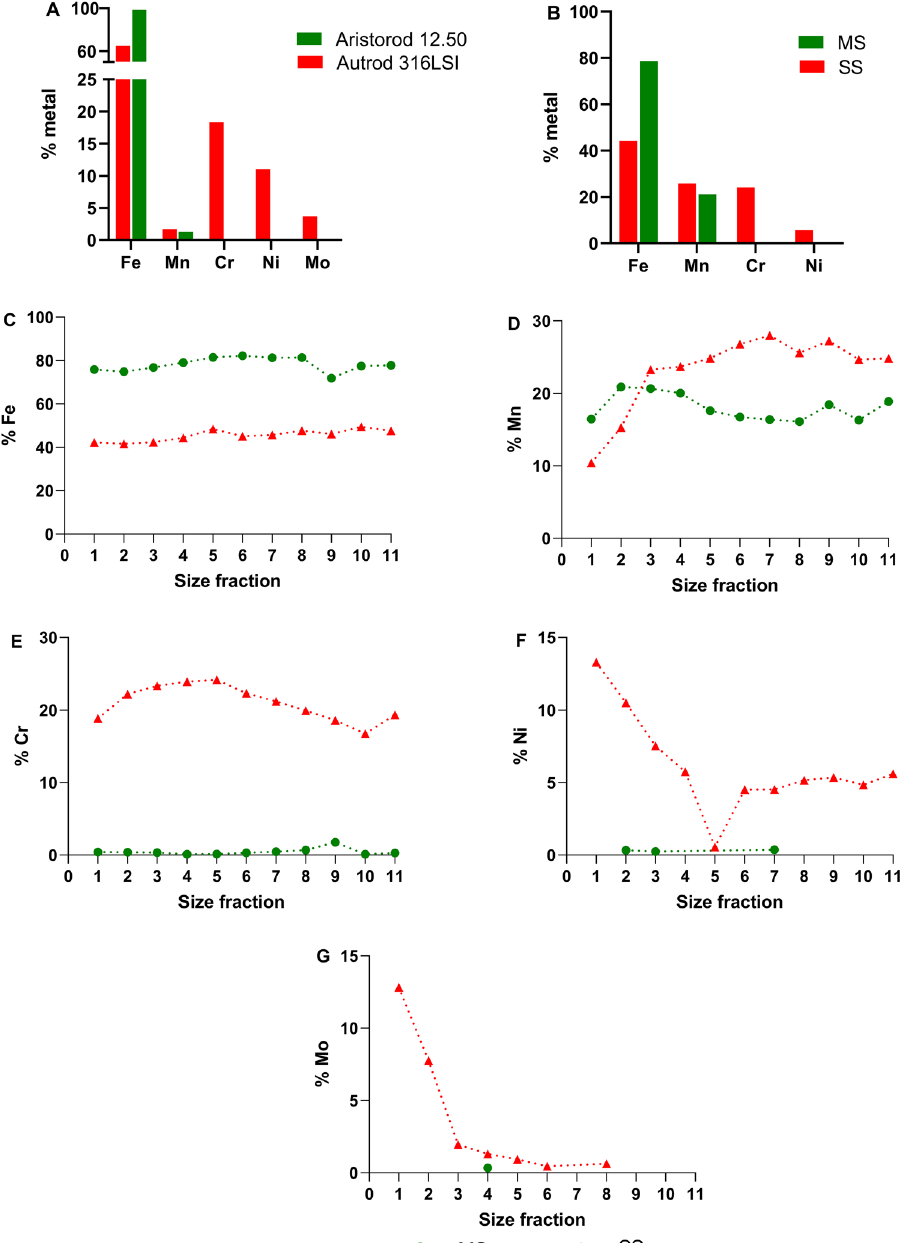
Figure 2. Characterization of welding particles by PIXE. Quantitative metal composition was determined by PIXE on the welding electrodes ( A ), collected particles ( B ) as well as different particle size fractions during the aerosol generation ( C – G ). Percentage refers to metal content which was normalized to 100% ( i.e. it disregards the presence of oxygen). The D50 (µm) for the collection stages are the following: 1—0.04 µm, 2—0.09